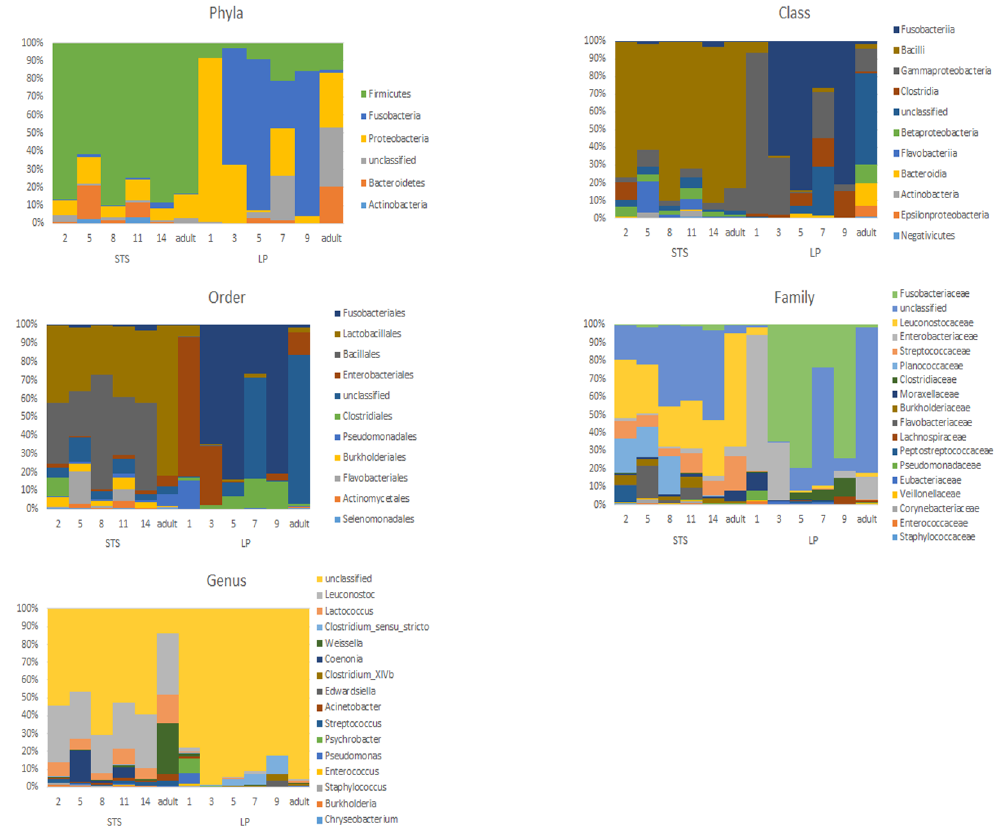
Fig 4. Bar charts showing the taxonomic diversity of LP and STS samples (proportion of total reads assigned to each taxon). Chick age is shown in weeks.